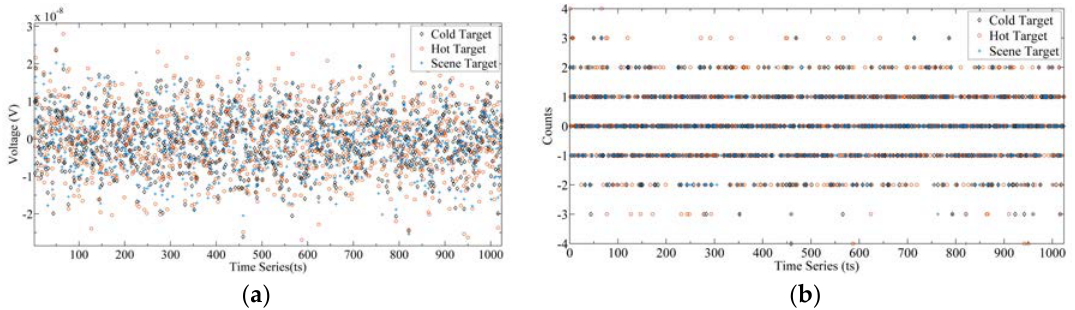
Figure 9. Frontend output signal of the cold target, hot target, and scene target: ( a ) Output analog signals; ( b ) output signals after 3-bit quantization.